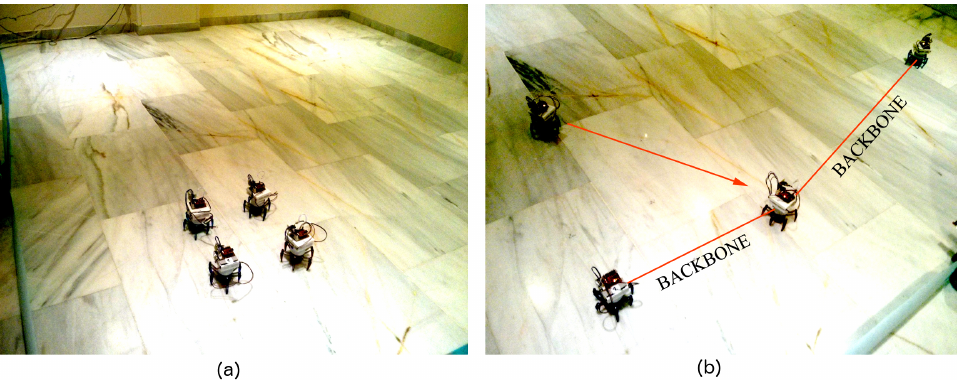
Figure 10. Deployment for four robots in a real environment using BDA: ( a ) initial configuration; ( b ) final